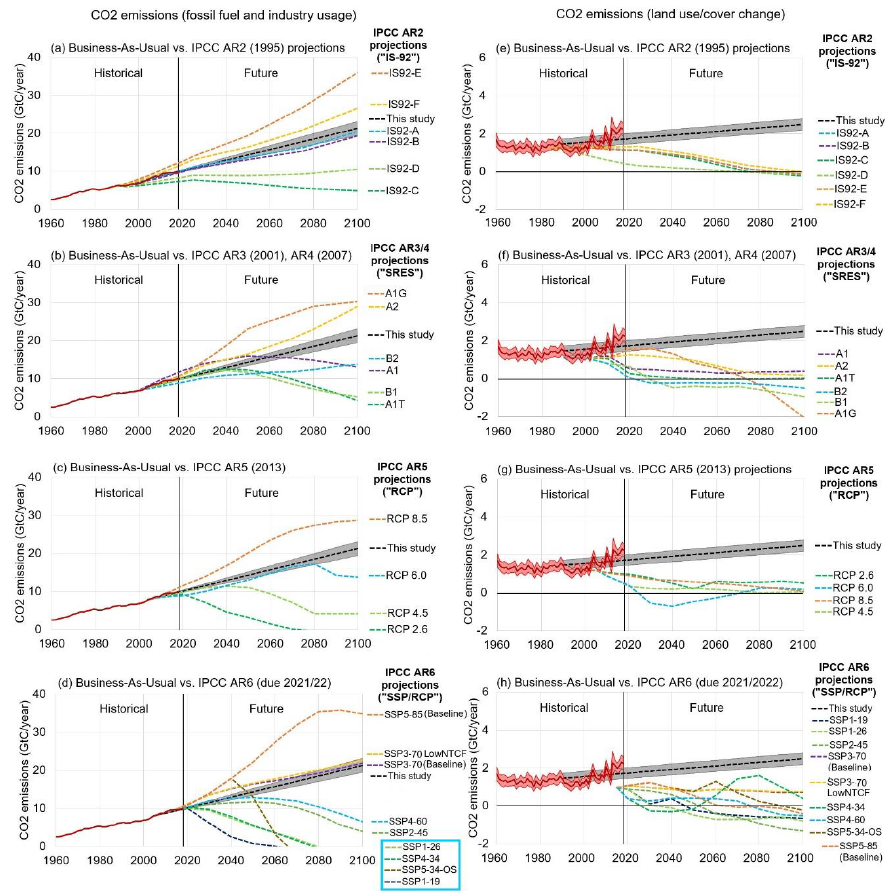
Figure 3. Comparison of the new "Business-As-Usual" projections of future CO 2 emissions for ( a )–( d ) fossil fuel and industry usage and ( e )–( h ) changes in land use/land cover with the various projections considered by the IPCC's Assessment Reports. Note that the vertical axes for ( e )–( h ) have a different scale than for ( a )–( d ). The horizontal axes correspond to years. Details on the projections are provided in Table 2.